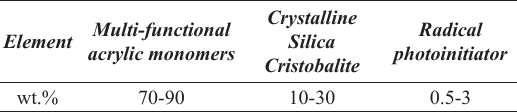
Table 3. Composition of the R&R Ultra-Vest gypsum (wt.%) (according to the manufacturer). Crystalline High molecular Calcium Sulfate Element Silica Quartz polyol Hemihydrate wt.%